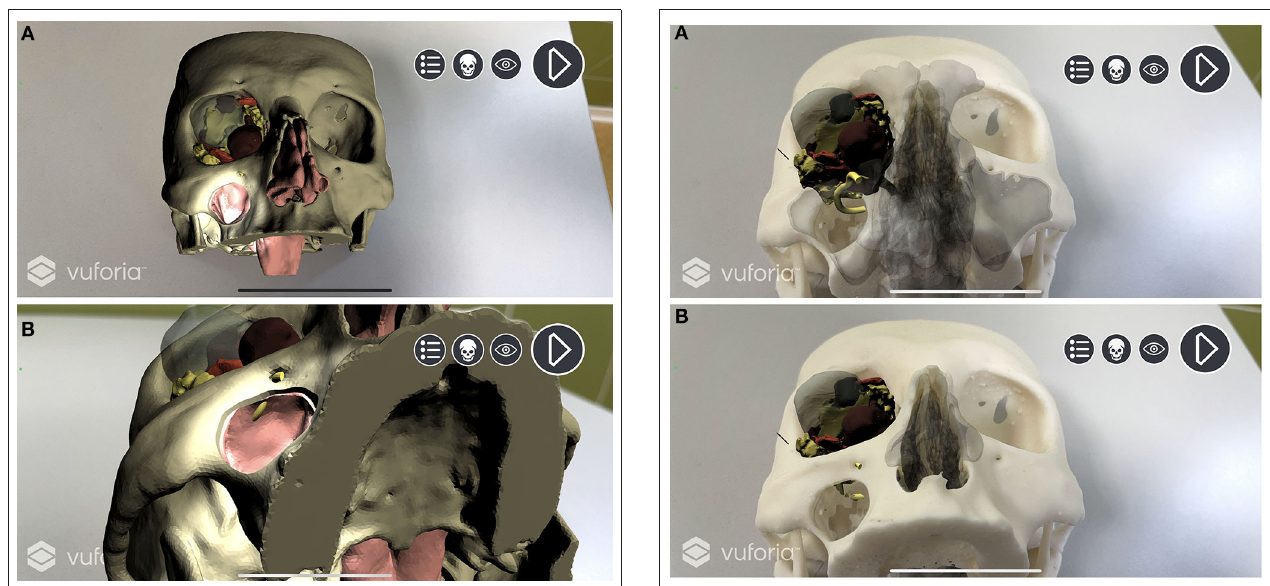
FIGURE 5 | Augmented reality simulation. All components of the virtual model are rendered over the physical 3D printed model. (A) Frontal view with simulated lightning over the transmaxillary portal. (B) Inferior view of the mucosal sinus roof with the infraorbital nerve highlighted in yellow.